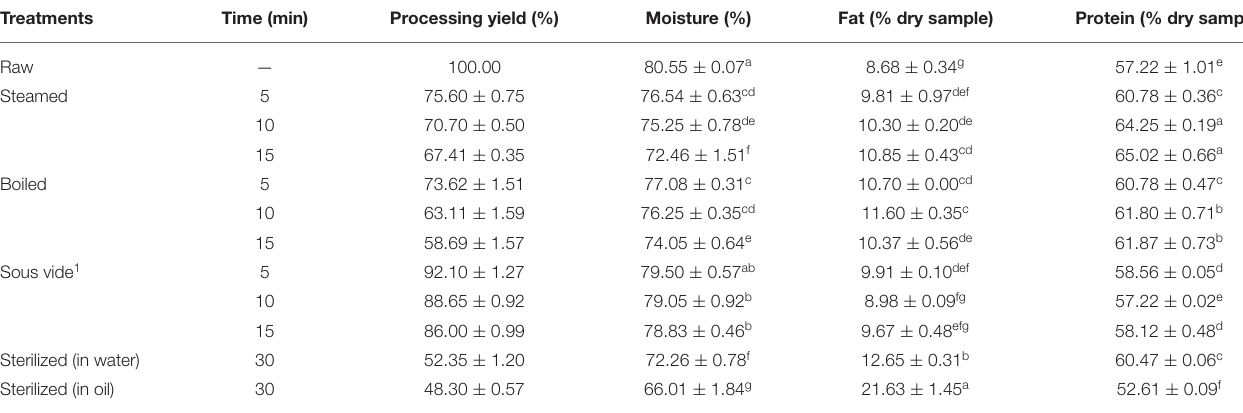
TABLE 1 | Processing yield (%) and composition of raw and processed oysters (per 100g of dry matter). Treatments